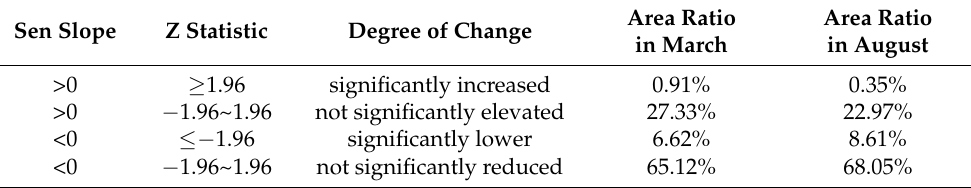
Table 5. The percentage of areas with changed SSS according to different degree of confidence.